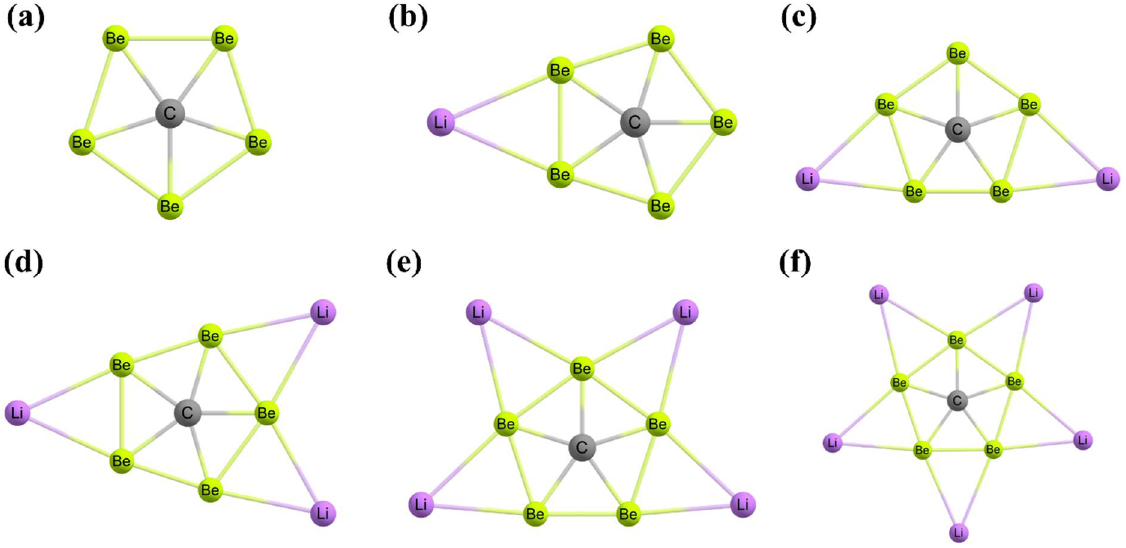
Figure 21. ( a ) The symmetric structures CBe 5 and CBe 54− are ppC species. The neutral and tetraan- ionic forms have the same shape but different bond lengths. The global minimum structures of ( b )